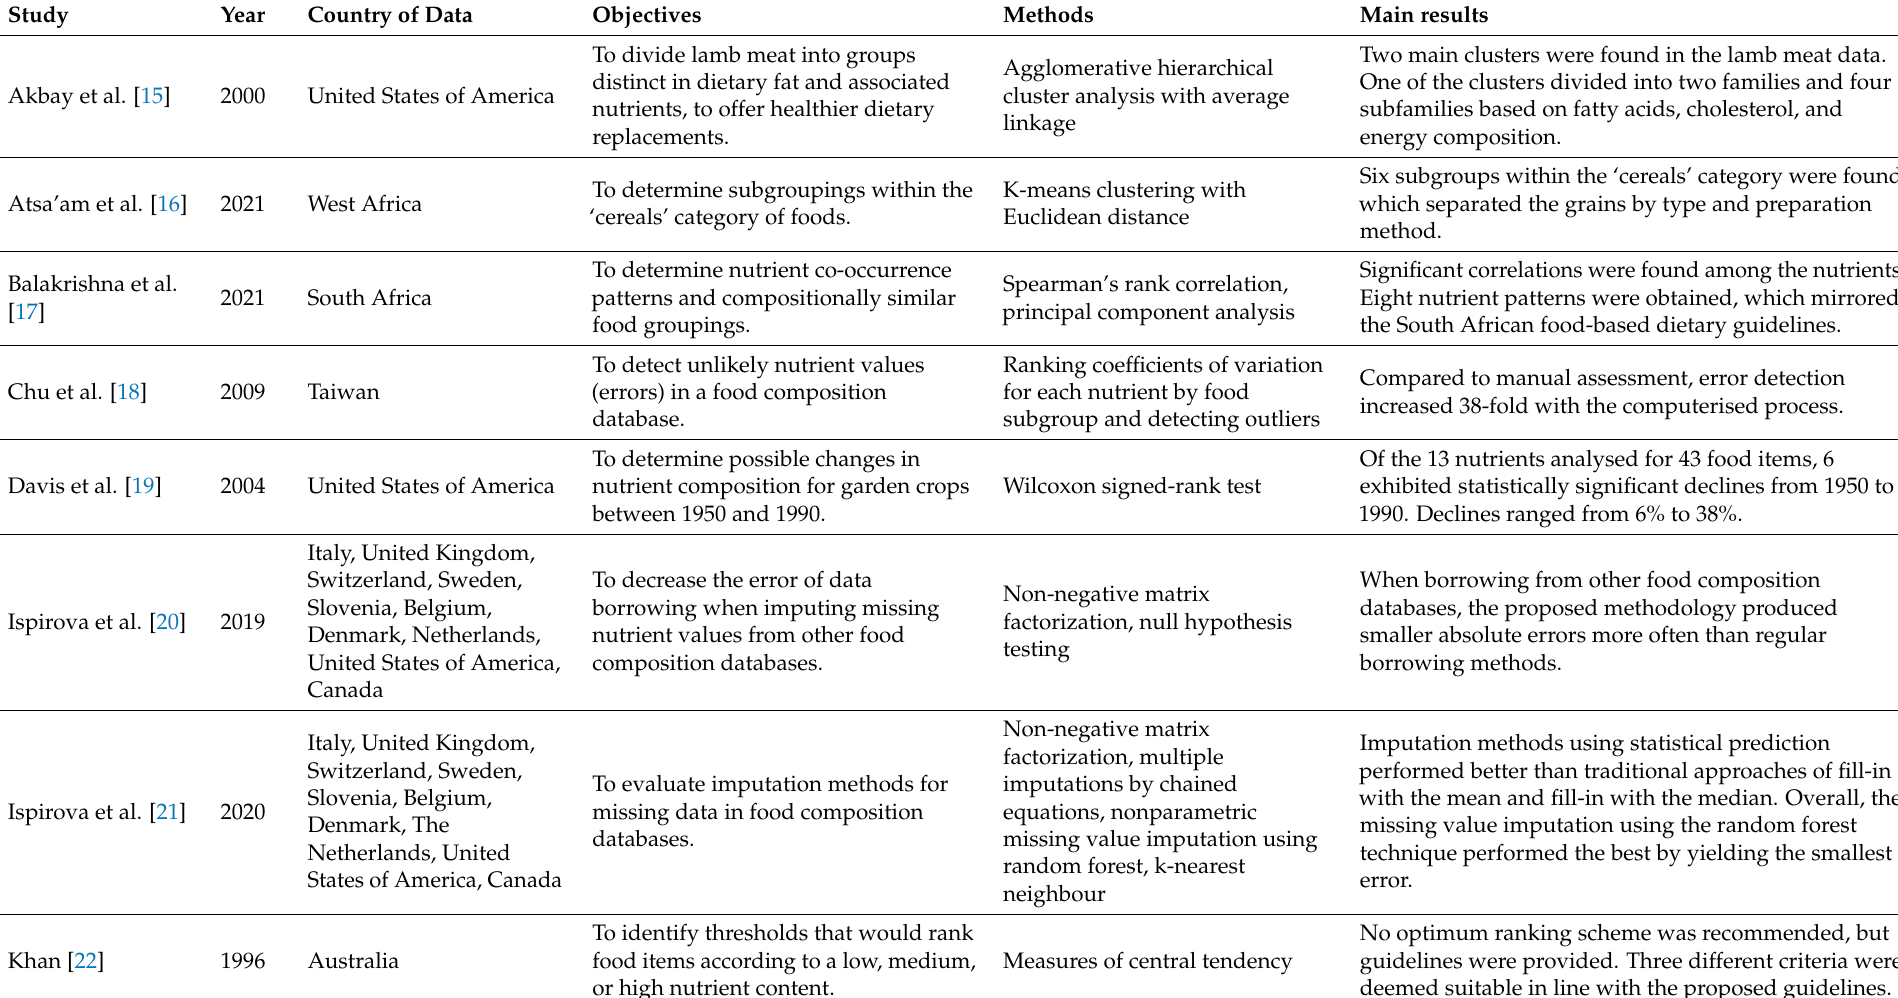
Table 1. Description of included